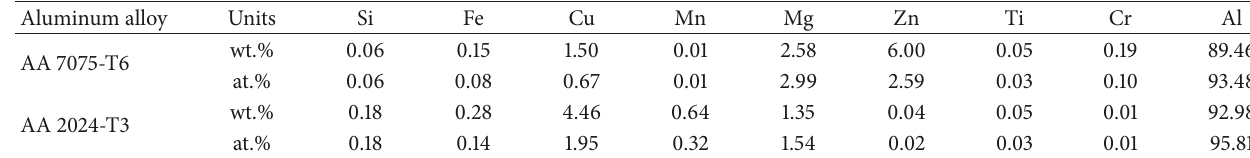
Table 2: Chemical compositions of the as-received, commercial aluminum alloys (AA) 7075-T6 and 2024-T3. Aluminum